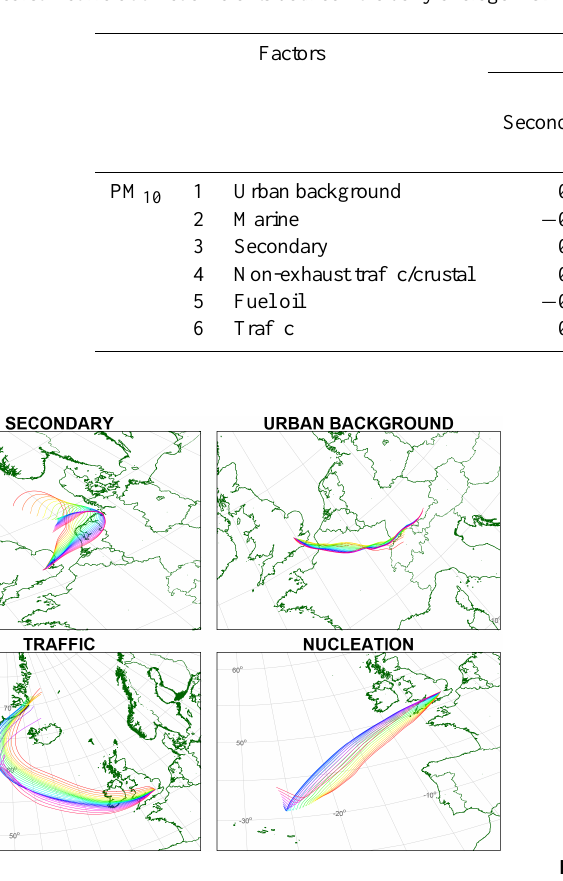
Figure 9. Back air mass trajectories corresponding to the verti- cal red lines in Fig. 8, which indicate the day each factor has the highest daily contribution to NSD: 24 March 2012 – secondary; 1 October 2011 – urban background; 27 January 2012 – traffic; 17 July 2012 – nucleation.